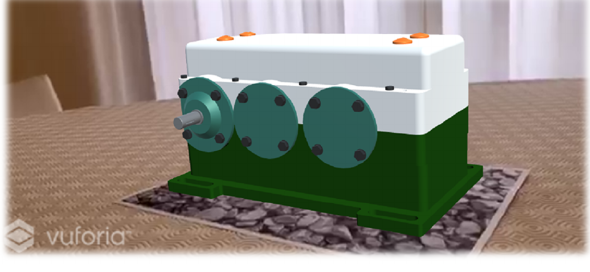
Figure 14. Gearbox in AR.